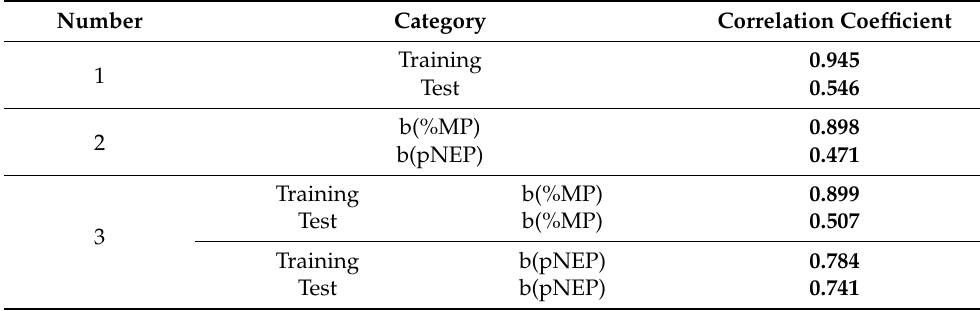
Table 5. The values of linear correlation coefficients for neural network assessment indicators (sine function